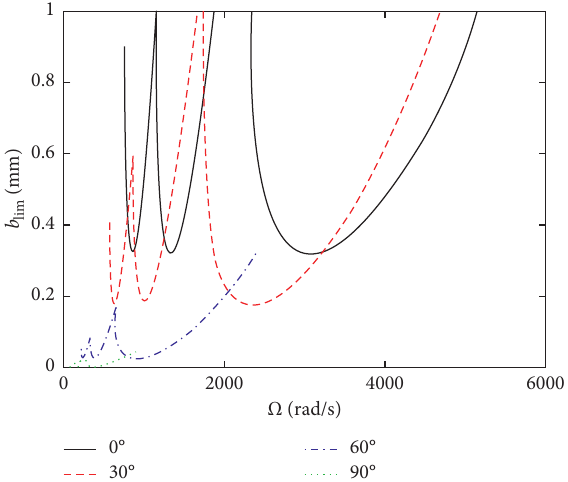
Figure 12: Effect of the structural damping bar on primary res- onance curves.